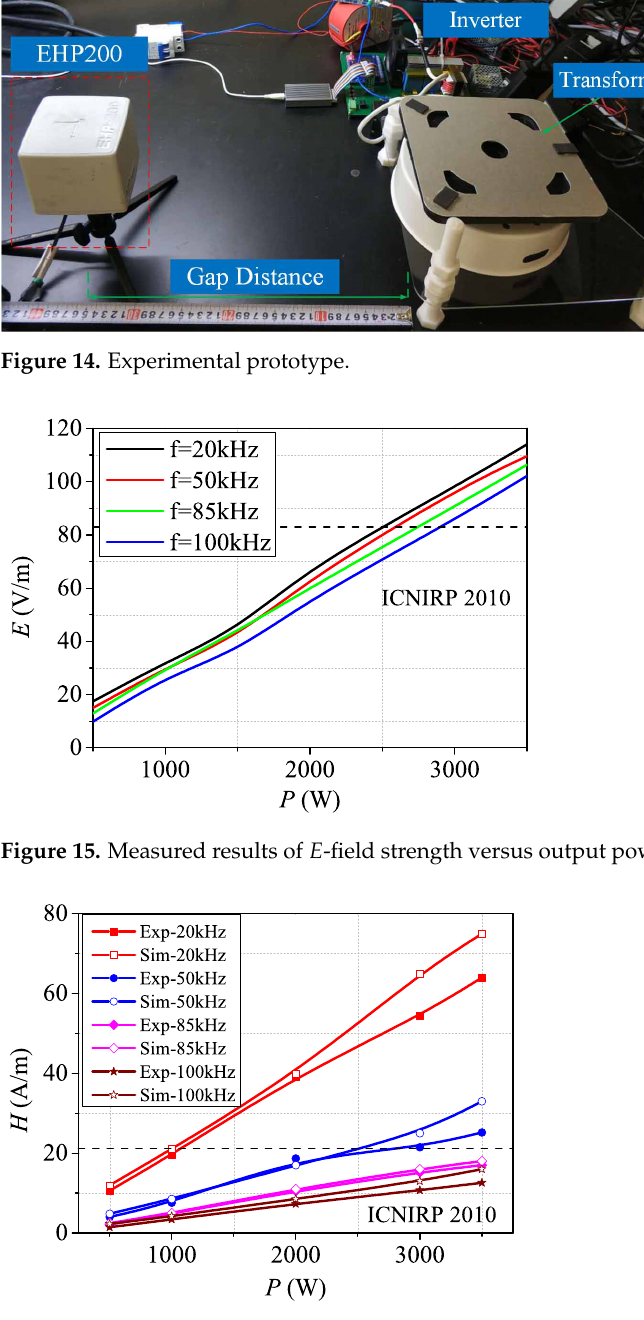
Figure 16. Measured results of H -field strength versus output power and operating